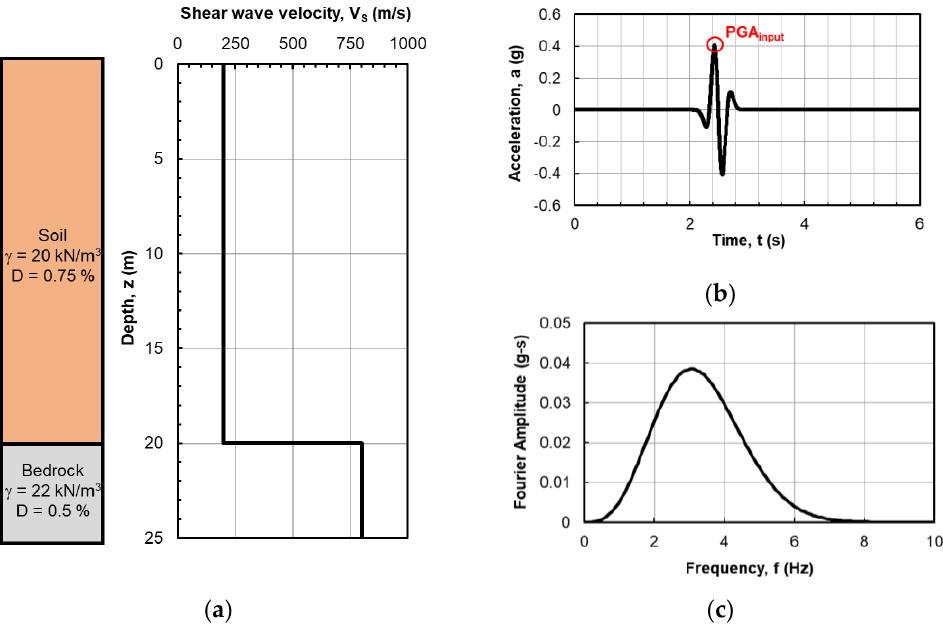
Figure 1. The ideal case considered in the analysis: Soil stratigraphy and shear wave velocity as a function of the depth ( a ); Reference seismic input on outcropping rock in terms of the time history of acceleration (the PGA attained is highlighted with a symbol) ( b ) and the Fourier amplitude spectrum ( c ).